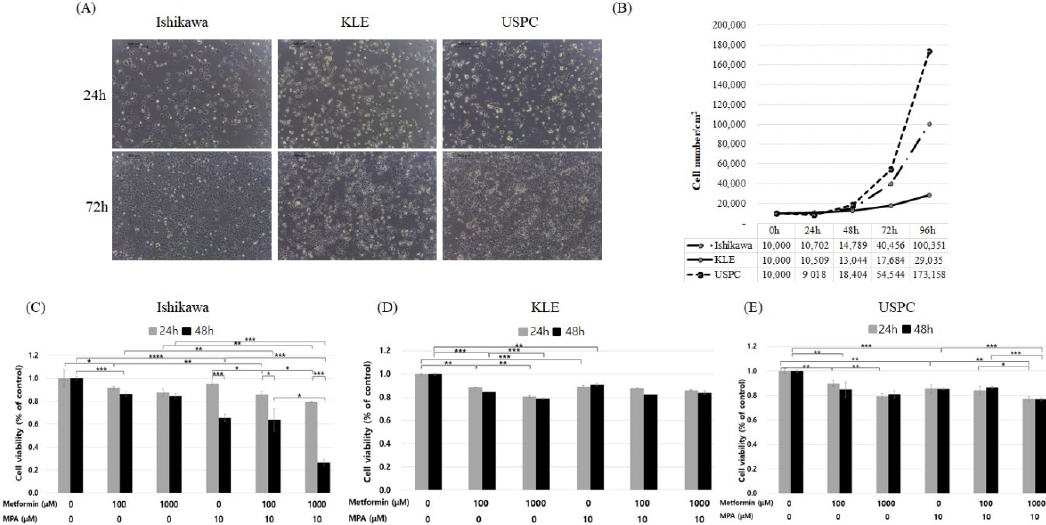
Figure 1. Cell growth and growth inhibition by metformin and medroxyprogesterone (MPA) in three endometrial cancer cell lines: Ishikawa, KLE, and USPC. ( A ) Cell morphology and number at 24 h and 72 h, ( B ) cell growth rate (0, 24, 48, 72, and 96 h), cell viability after treatment of different dose combinations of MPA (0, 10 µM) and metformin (0, 100, 1000 µM) in Ishikawa ( C ), KLE ( D ), and USPC cells ( E ). Each experiment was independently performed in triplicate: results are expressed as mean ± standard deviation ( C – E ). Multiple testing correction was performed using Bonferroni adjustment and Bonferroni corrected p-values were used for statistical significance ( C – E ). * p <